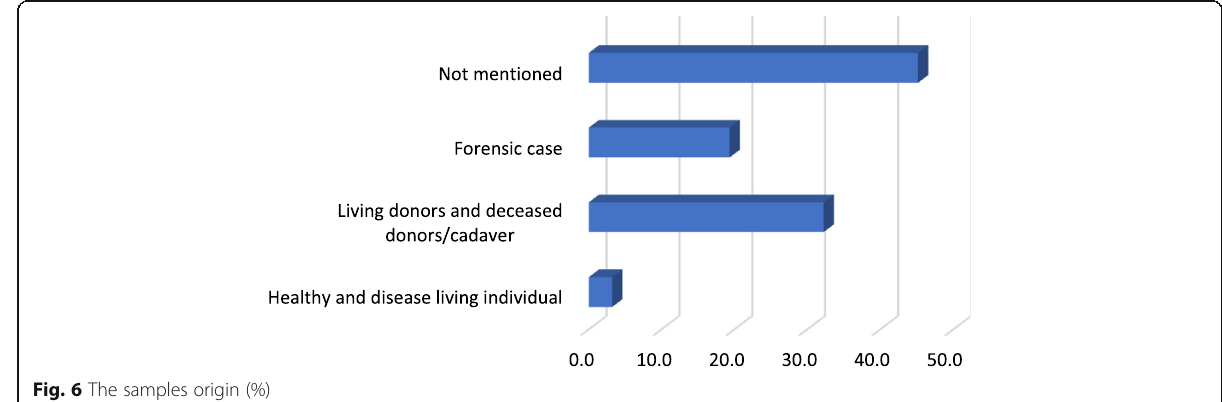
Fig. 6 The samples origin (%)